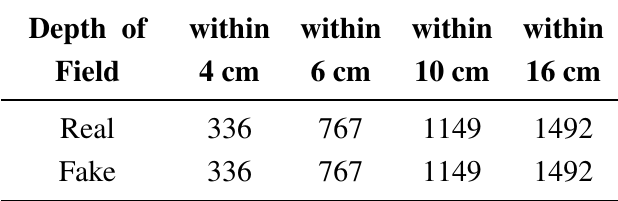
Table 1. The number of pairs of images in the